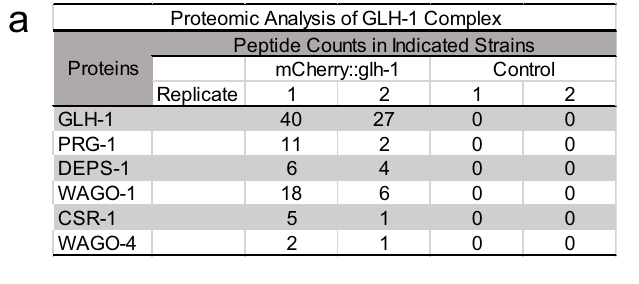
Fig. 1 | The GLH/VASA helicases GLH-1 and GLH-4 promote the localization of germ granule factors. a Proteomic analyses of GLH-1 complex. The numbers of peptides identi fi ed in two independent pull-down experiments are shown. b Fluorescent micrographs showthe localization ofthe speci fi c proteins known to be enriched in P granules in the wild type or the glh-1 glh-4 mutant in the adult germline (left) and in the four-cell embryo (right). Bar, 10 micrometers.